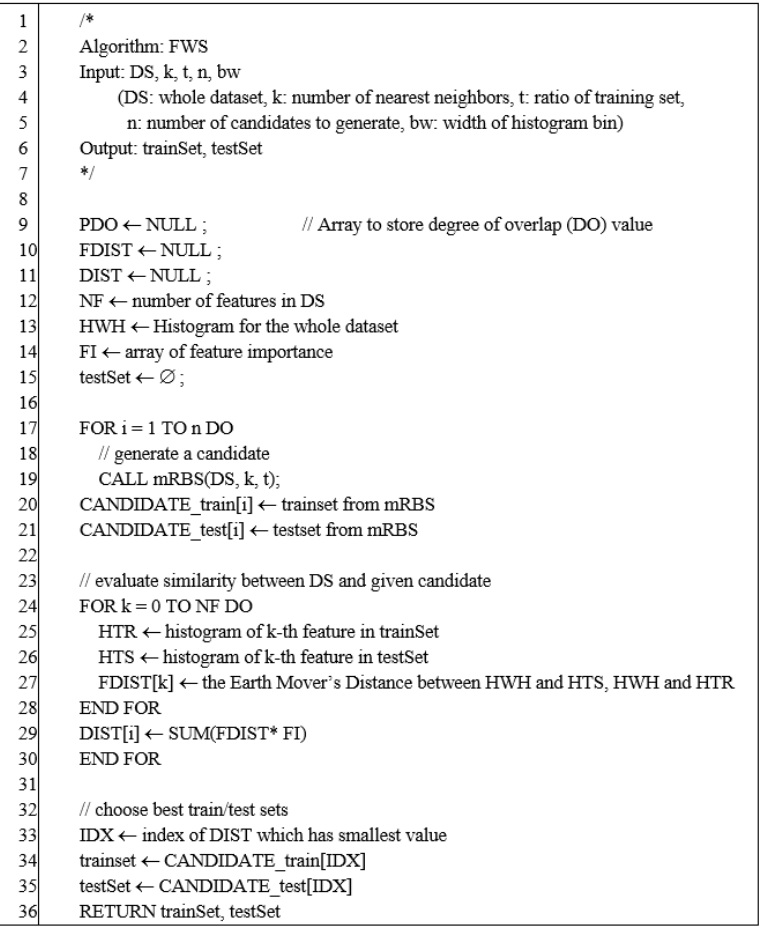
Figure 7. The pseudocode of feature-weighted sampling (FWS) method. 226